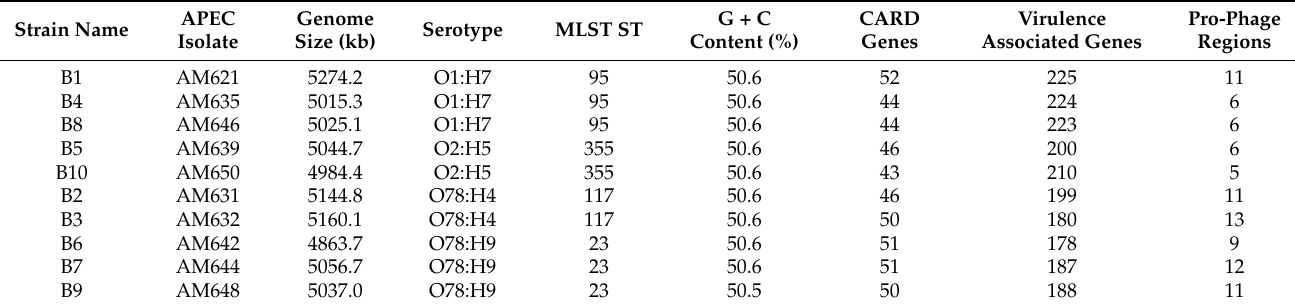
Table 1. Avian pathogenic Escherichia coli (APEC) strain